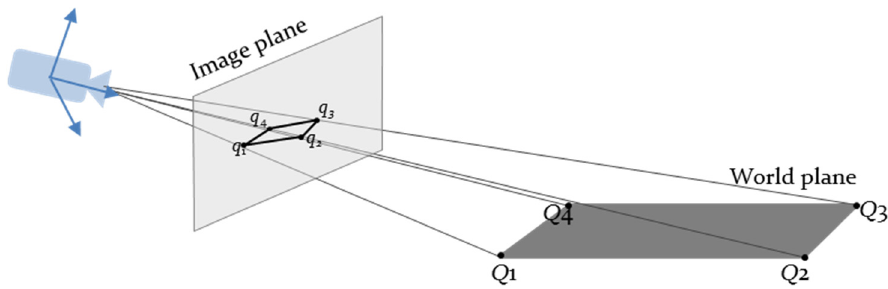
Figure 2. Homogeneous transformation between world and image planes.